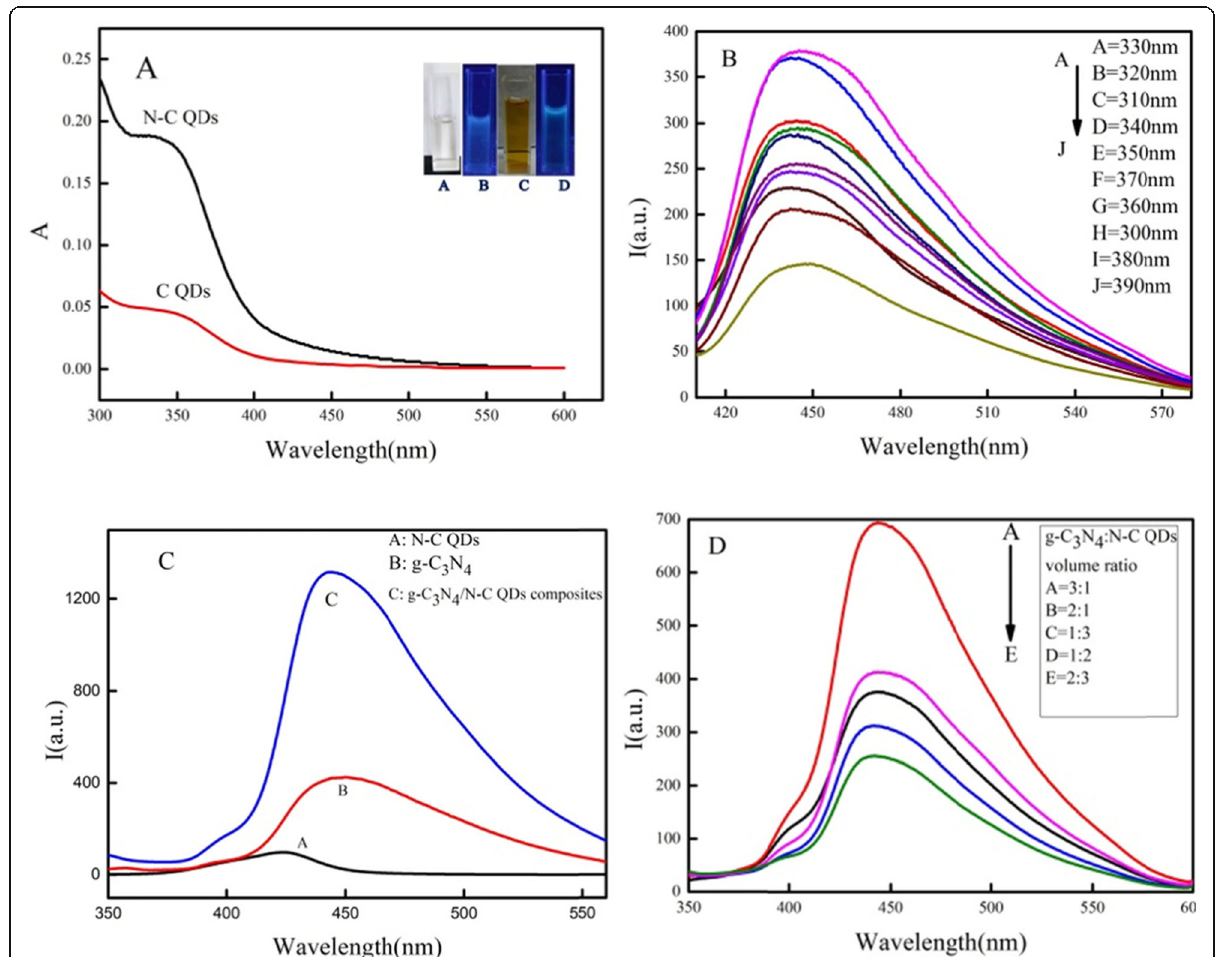
Fig. 2 Optical characteristics of C QDs, N-C QDs, g-C 3 N 4 : N – C QDs composites ( a Uv-vis properties of C QDs, N-C QDs. b The excite properties of composites. c The properties of QDs. d The optimal proportion of